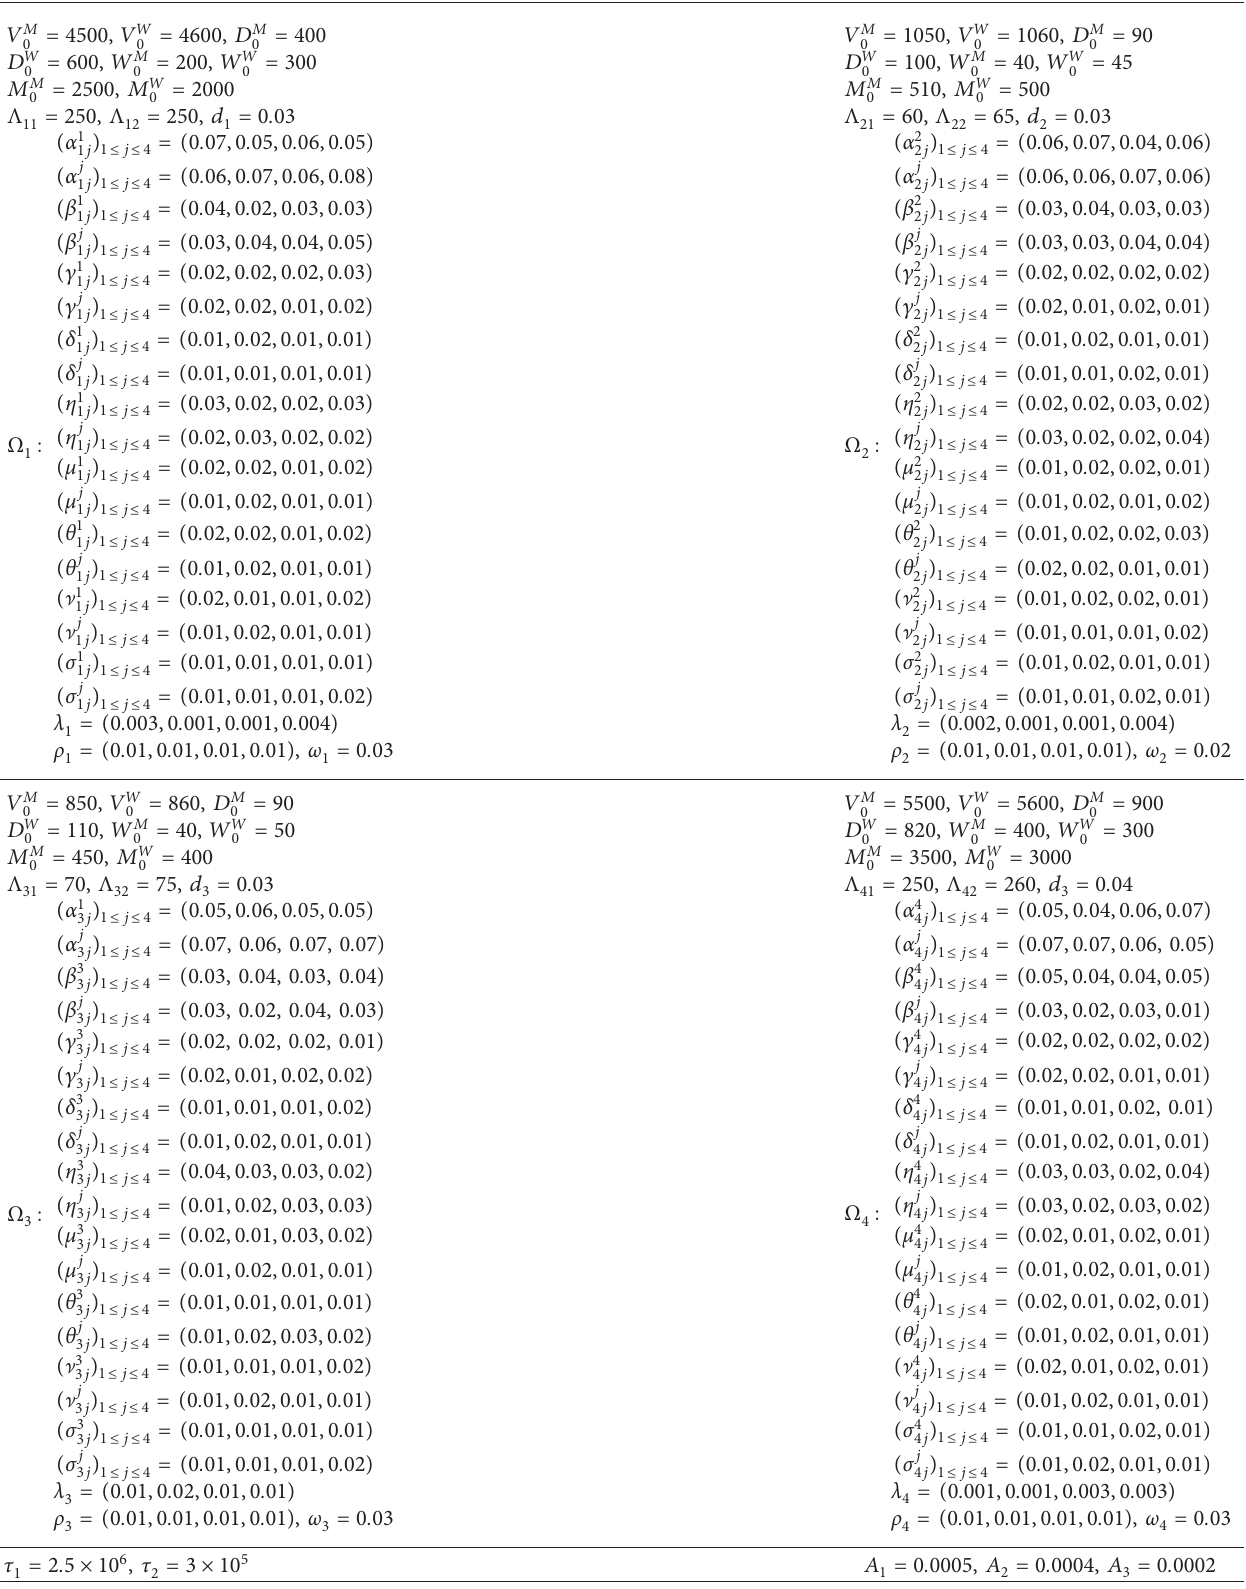
Table 2: Parameters values associated with discrete-time systems (9)–(16) and with optimal control problem